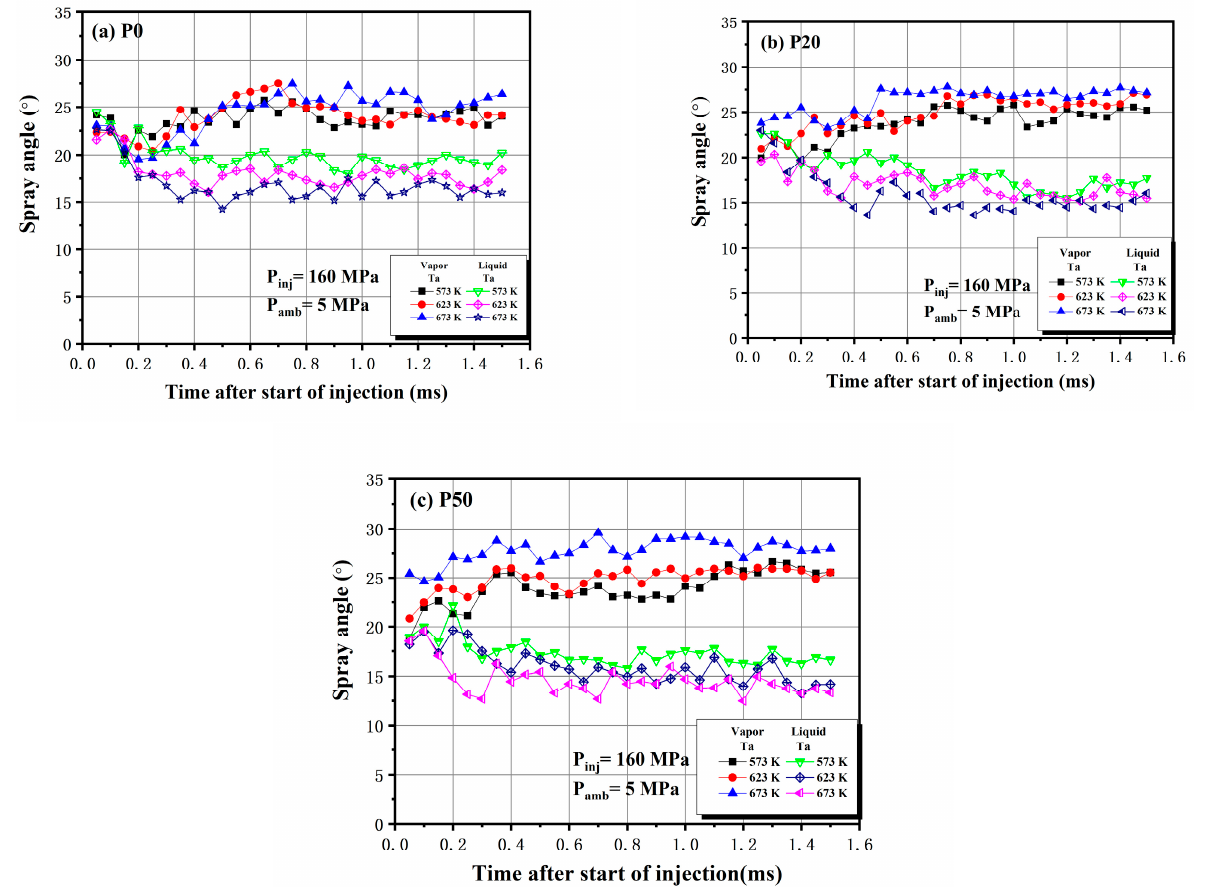
Figure 8. Cone angle of the three blends at different temperatures: ( a ) P0, ( b ) P20, ( c ) P50. Figure 9 shows the vapor and liquid phase projected areas of the three tested fuels at different ambient temperatures. It can be seen that the vapor and liquid phase projection areas of P0 are not much different for the ambient temperatures of 573 K and 623 K and before 0.9 ms. However, the vapor phase projection area of P0 after 0.5 ms at ambient temperature of 673 K is larger than the other two temperatures. The results for P20 and P50 show that the higher the temperature, the larger the vapor phase projection area and smaller the liquid phase projection area. It shows that the increase in pure diesel in the temperature range (within 623 K) has little influence on the evaporation characteristics and spray diffusion, while the fuel blend with PODE 3-4 still has good diffusion capability and the ambient temperature, the projected area decreases. When the temperature is 673